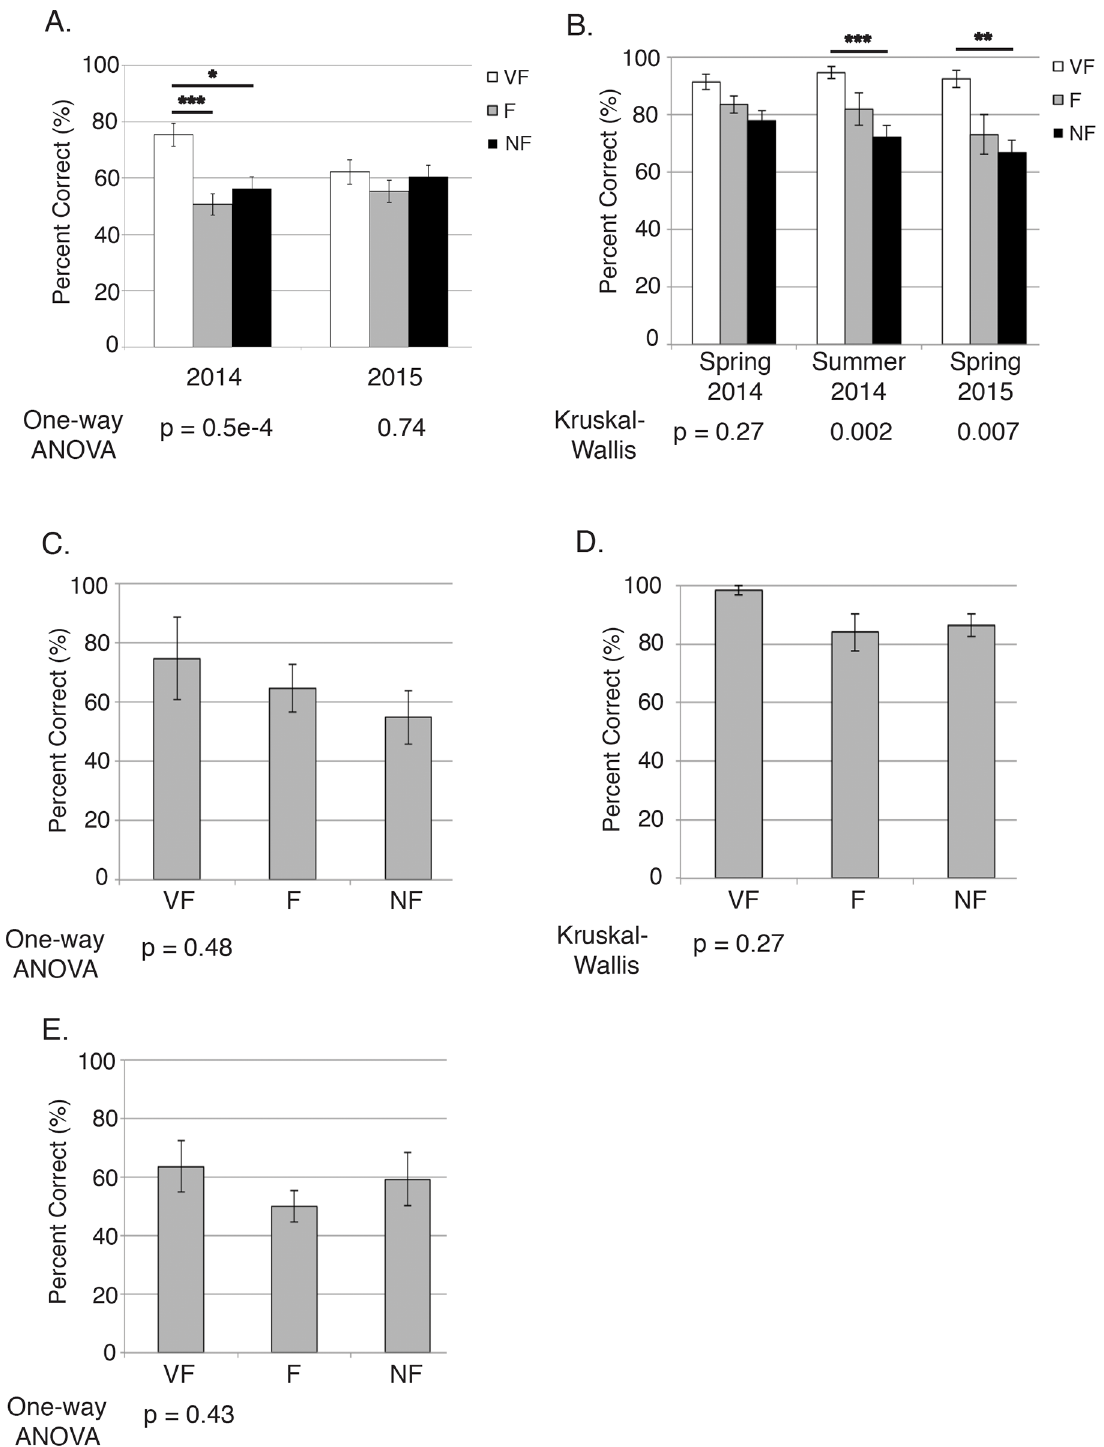
Fig 1. Student performance on exam questions in the context of question familiarity. Student performance on (A) Molecular Biology (MB) and (B) Human Anatomy (A) exam questions sorted by familiarity according to prerequisite course lecture slides. For the MB analysis, exam questions were analyzed from both the 2014 and 2015 courses and significant differences were determined using a one-way ANOVA followed by Tukey ’ s test (comparing VF vs. F, F vs. NF, and VF vs. NF performance). Because the A data were not normally distributed, they were analyzed with the Kruskal-Wallis test and the Wilcoxon signed-rank test and Bonferroni correction. * p (cid:1) 0.05, ** p (cid:1) 0.01, *** p (cid:1) 0.001. Student performance on twelve randomly selected 2014 (C)